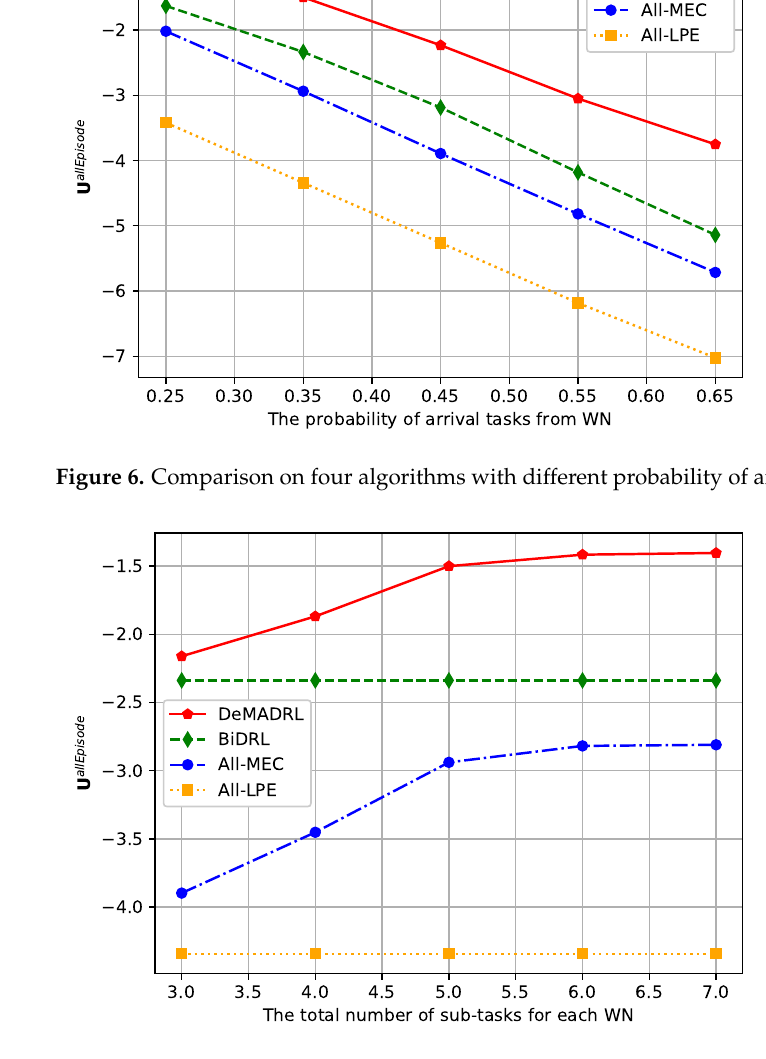
Figure 7. Comparison on four algorithms with different divided number of subtasks for each